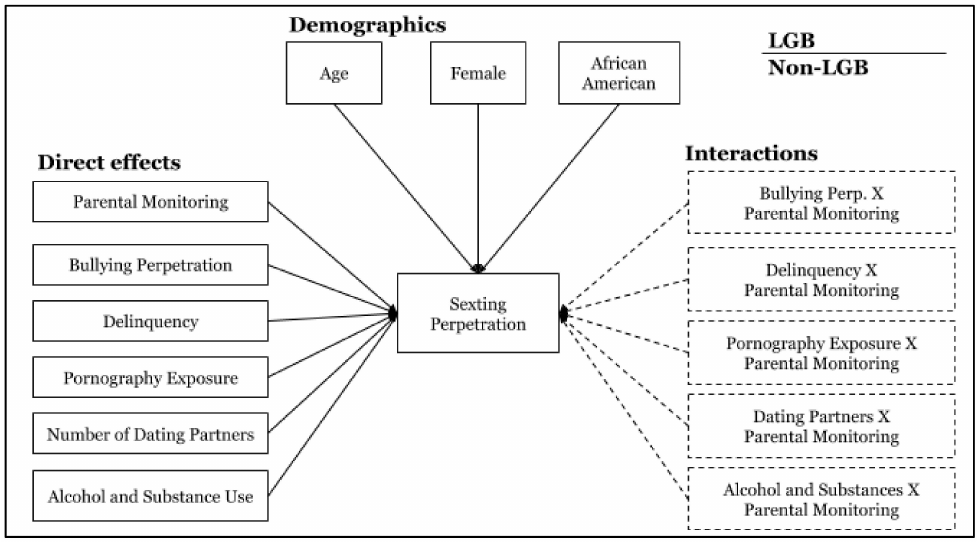
Figure 1. Final path analysis